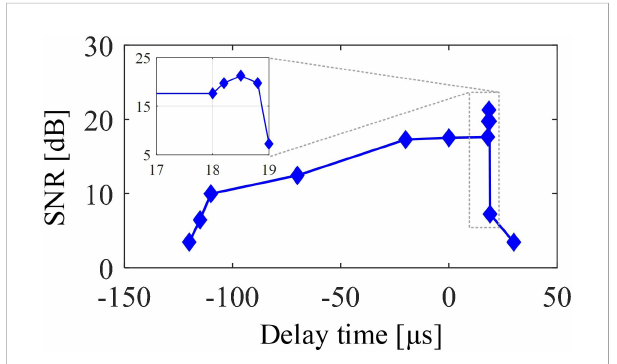
FIGURE 4 The fi gure of signal-to-noise ratio changing with spectral acquisition delay.